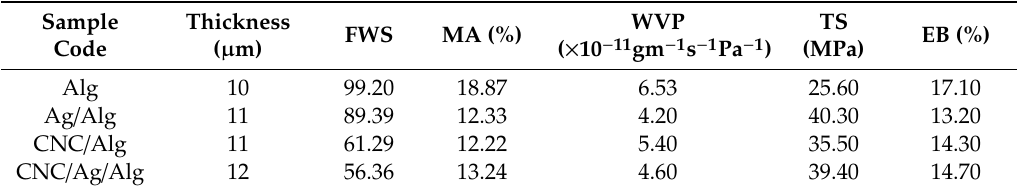
Table 1. Values of thickness, film water solubility (FWS), moisture absorption (MA), water vapor permeation (WVP), Tensile Strength (TS) and Elongation at break (EB) (%) for Alg, Ag / Alg, CNC / Alg, and CNC / Ag / Alg